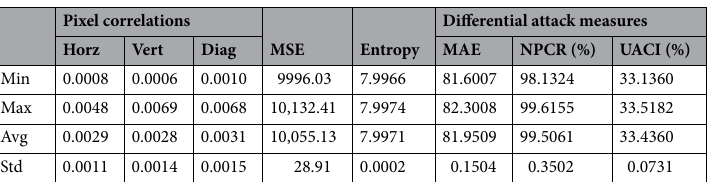
Figure 12. Statistical analysis results for encrypted Peppers using 30 different system keys ( K 1 , K 2 , . . . , K 30 ): ( a ) correlation box plot, ( b ) entropy histogram, ( c ) NPCR histogram, and ( d ) UACI histogram. Pixel